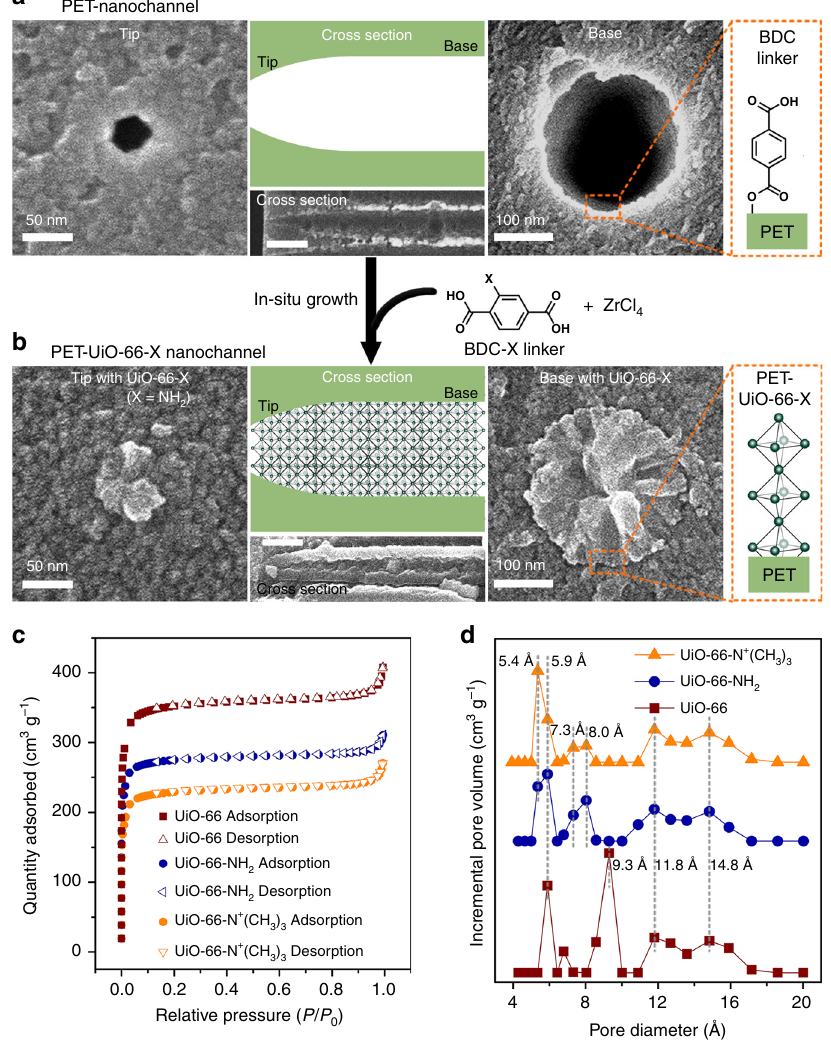
Fig. 2 Fabrication and characterization of PET-UiO-66-X nanochannels. a Schematic of a single bullet-shaped nanochannel and SEM images of the channel tip, cross section (the scale bar is 500 nm) and base. Average tip diameter is 36.3 ± 5.6 nm, while average base diameter is 328.3 ± 35.2 nm. The PET nanochannel surface possesses BDC linkers for in-situ growth of UiO-66-X MOFs. b Schematic of a PET-UiO-66-X nanochannel and SEM images of the nanochannel tip, cross section (the scale bar is 500 nm) and base (SEM images of PET-UiO-66-NH 2 are shown as an example). Schematic of UiO-66-X crystal structure along the PET-nanochannel surface. c N 2 adsorption/desorption isotherms of UiO-66, UiO-66-NH 2 , and UiO-66-N + (CH 3 ) 3 . d Pore size distributions of UiO-66-X MOFs. The distributions for UiO-66-NH 2 and UiO-66-N + (CH 3 ) 3 are displayed vertically for ease of viewing. Pore size decreases as MOFs functional group size